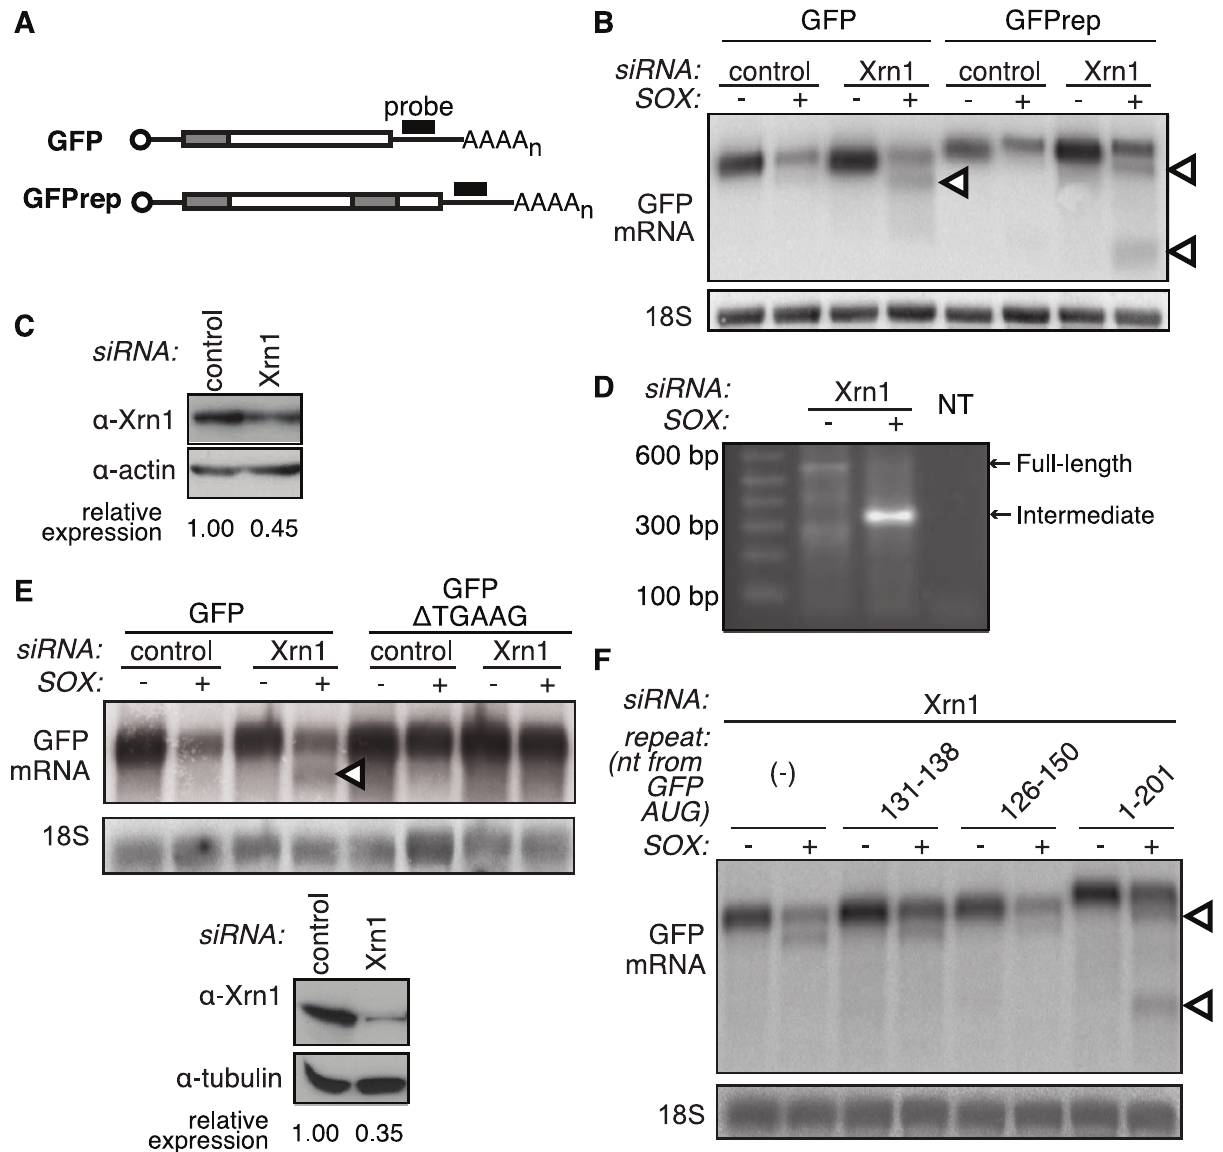
Figure 3. A specific element in the GFP coding region is sufficient for production of degradation intermediates by SOX. (A) The modified GFP mRNA (GFPrep) contains an internal repeat of the first 201 basepairs of the GFP coding region (grey shaded area). (B) 293T cells were treated with control or Xrn1 siRNAs, then transfected with GFP or GFPrep + / 2 SOX. RNA was Northern blotted with a GFP 3 9 UTR or an 18S probe. Arrowheads denote degradation intermediates. (C) Western blot shows the level of Xrn1 depletion in the experiment depicted in panel B, with actin as a loading control. (D) 5 9 RACE was carried out on total RNA from 293T cells transfected with Xrn1 siRNAs and a GFP expression vector in the presence or absence of SOX. An internal GFP primer and a primer to the adapter ligated to the 5 9 end of the RNAs were used to amplify GFP in each sample. Full length refers to the band corresponding to the intact GFP transcript, intermediate refers to the , 300 bp band preferentially amplified in the lysate from SOX-expressing cells, and NT denotes the no template control. (E) A conserved TGAAG site located just upstream of the cleavage site was deleted from GFP to create GFP- D TGAAG. 293T cells were treated with control or Xrn1 siRNAs, then transfected with GFP or GFP D TGAAG in the presence or absence of SOX. RNA was Northern blotted with a GFP 3 9 UTR or 18S probe ( upper panels ). Arrowheads denote degradation intermediates. Western blot (lower panels) shows the level of Xrn1 depletion in experiments depicted in panel E and F, with tubulin as a loading control. (F) Modified GFP reporters bearing an internal duplication of sequences around the GFP cleavage site were transfected in 293T cells treated with Xrn1 siRNAs + / 2 SOX. The inserted nucleotides are numbered based on their position relative to the GFP start codon. GFPrep (nt 1–201) is included as a positive control. RNA was Northern blotted with a GFP 3 9 UTR or 18S probe. Arrowheads denote degradation